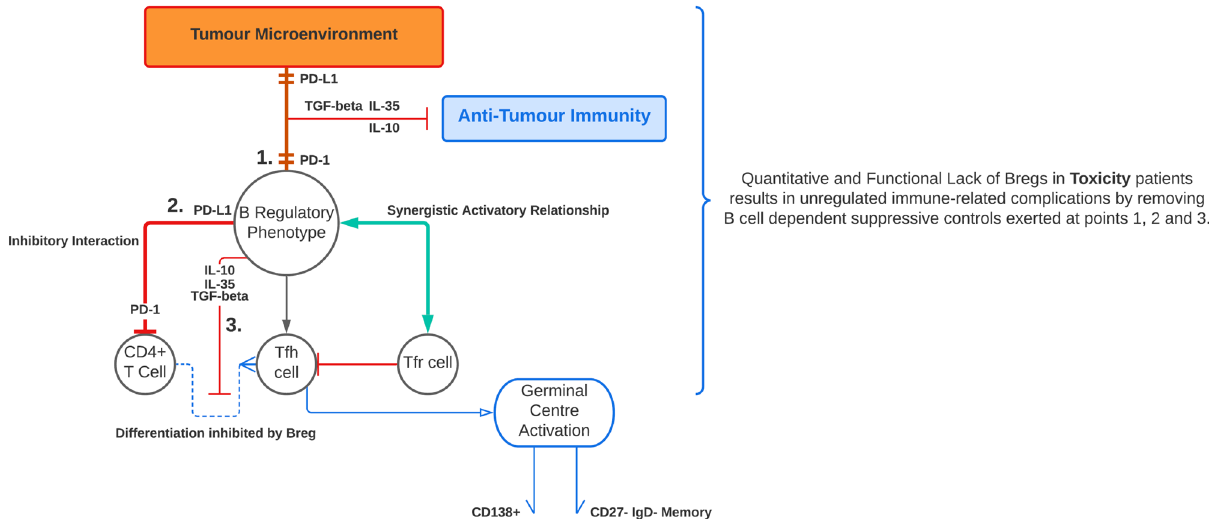
Fig. 8 A schematic demonstrating Breg dynamics and suppressive mechanisms between toxicity and non-toxicity patients. This schematic illustrates the interplay between Bregs, CD4 + T cells, Tfh and Tfr cells and the role of suppressive cytokines and the PD-1-PD-L1 axis in mediating downstream responses. Bregs can be PD-1 or PDL1-positive. Interactions with tumour cell PD-L1 (1) or upon encountering PD-L1 + cells, this PD-1 triggering results in the acquisition of suppressive functions with tumour-speci fi c T-cell immunity and promotes cancer growth via IL-10 production. Interaction